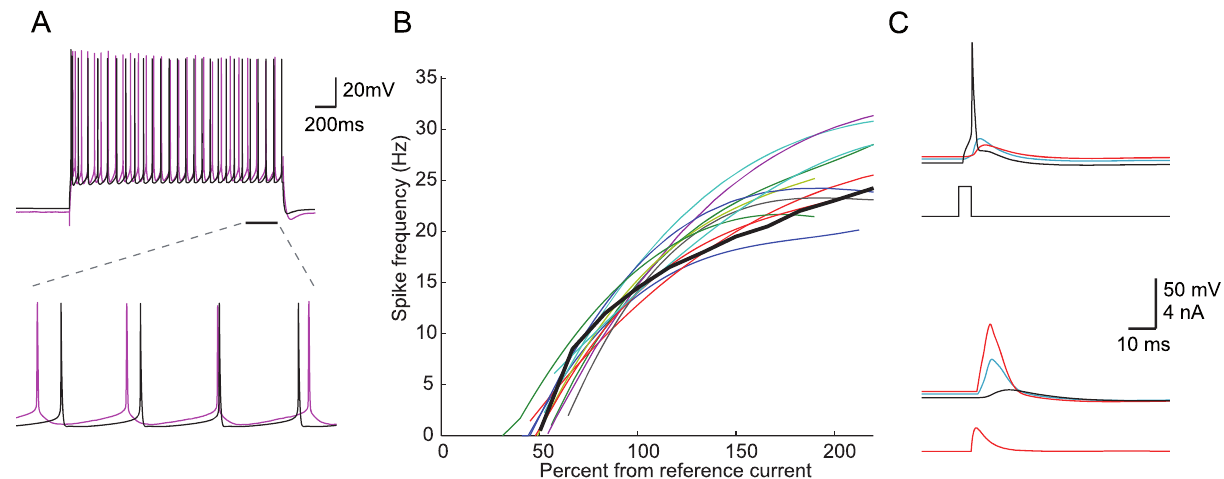
Figure 2. Models constrained only by perisomatic step current firing are not guaranteed to generate BAC firing. A. Top: model (black) response to a 2 second 793 pA depolarizing step current at the soma as compared to the corresponding experimental trace (magenta). Bottom: 300 ms of the response corresponding to the bar in the top part. B. f–I curve for the 11 L5b PCs (colors) and for the model (black). C. The apical tree in this model was only weakly excitable, exhibiting no active BAP (top), and was incapable of generating a dendritic Ca 2 + spike even under intense distal stimulation (bottom). All measures and definitions in C are as in Figure 1.